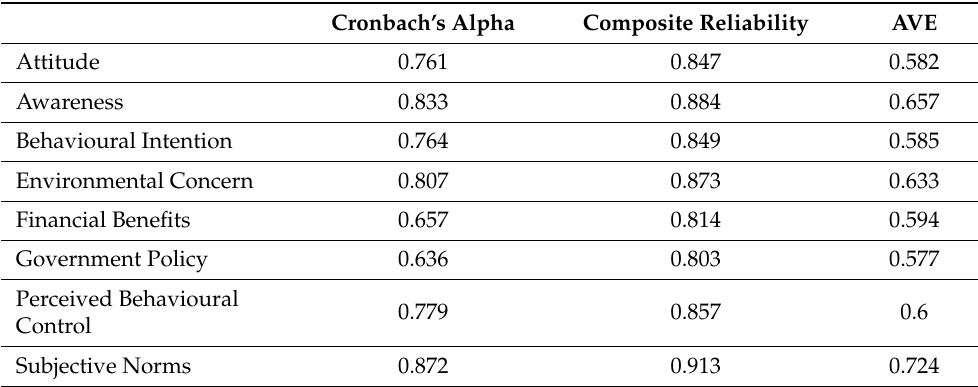
Table 2. Construct Reliability and Convergent Validity.